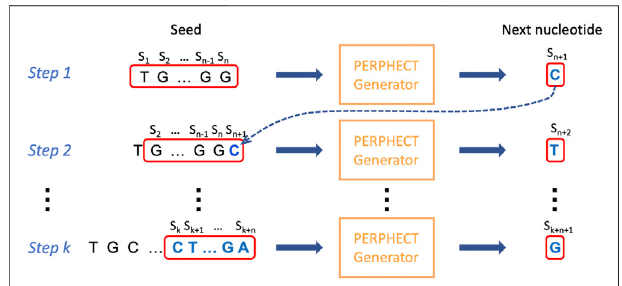
FIGURE6| Iterativegenerationofagenomicsequence.Rewritingphase of the phage genomic sequence by a trained model (A or B). The sequence of the fi rst n symbols ( n = seed length) is used as input to the model to start the generation process. The input sequence is processed by the model to generatethe next character inthe sequence. Then, at each iteration, the last n symbols of this growing sequence are passed to the model to generate the next symbol. The process continues until the desired sequence length is